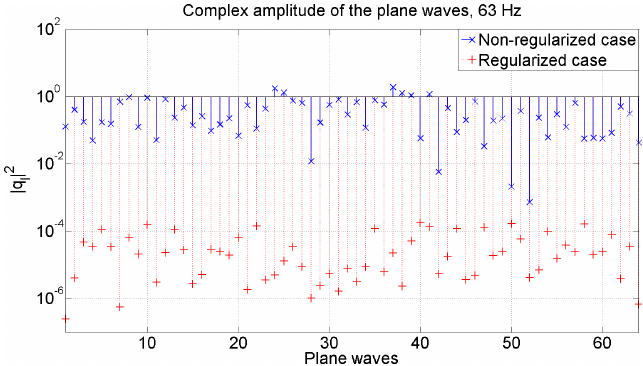
Figure 14. Comparison of the complex amplitude of the plane wave